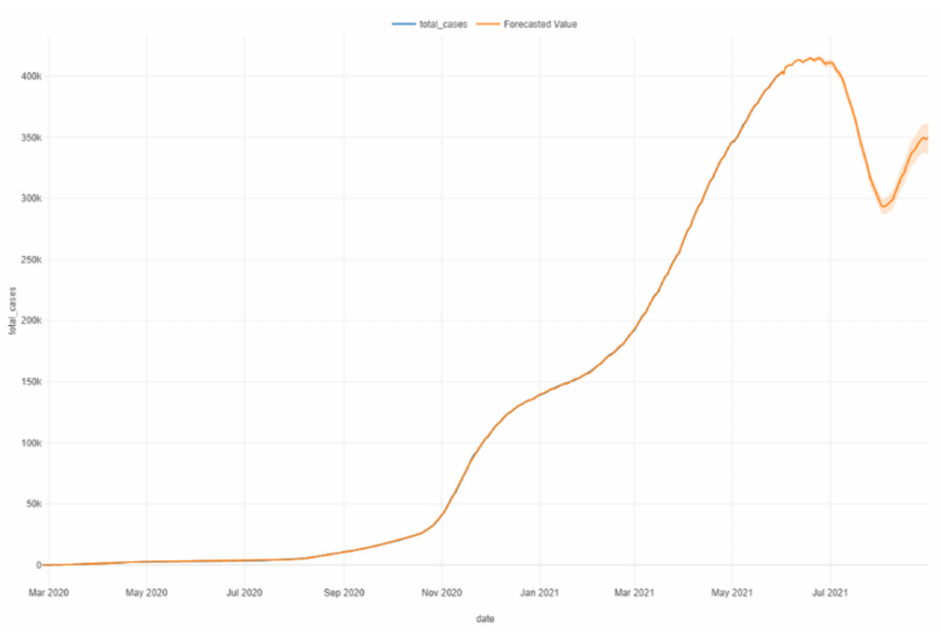
Figure 29. Prophet